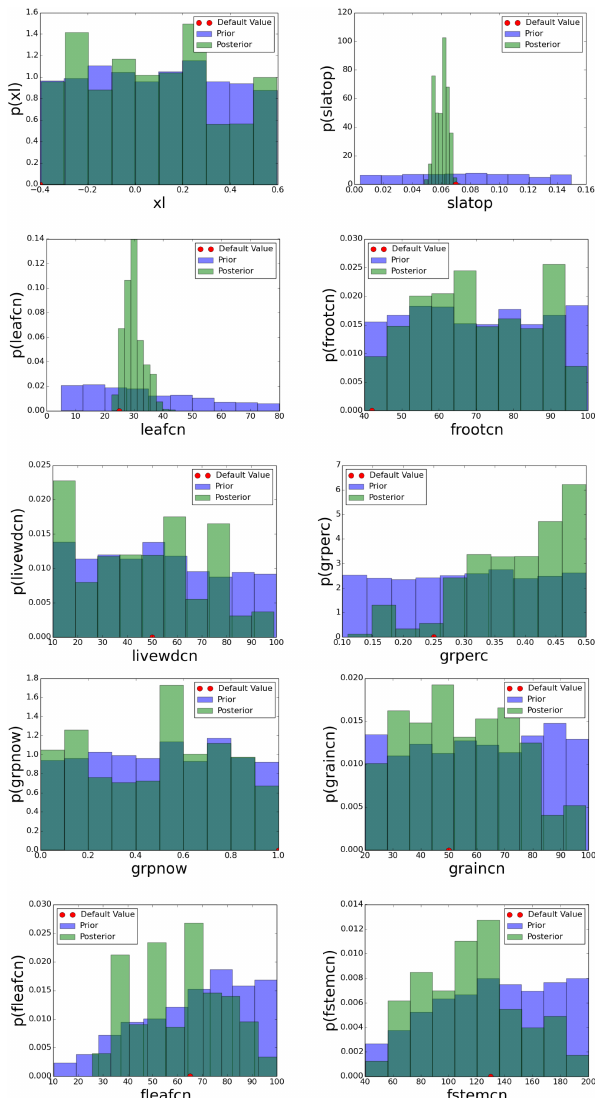
Figure 4. Calibration experiment (Bondville, IL): comparison of the posterior with the prior. The red dot indicates the default param- eter value. The figure continues on the next page.